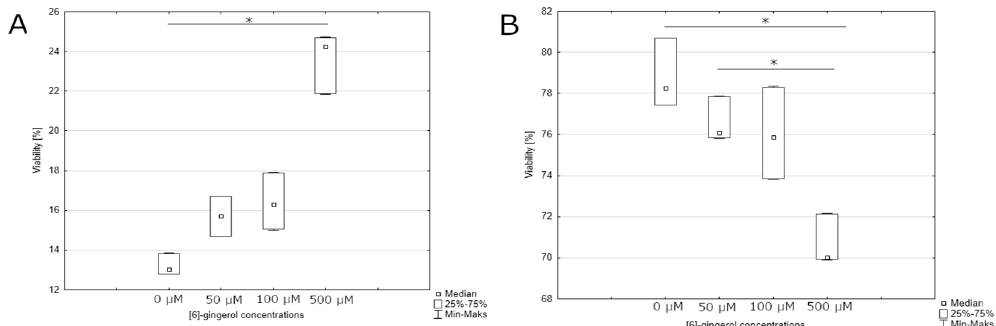
Figure 10. ( A ) assessment of the percentage of late stage of apoptotic or dead cells after 48 h incubation depending on the concentration of [6]-gingerol. The representative experiment is a median and a di ff erence between [6]-gingerol concentration and the control evaluated using ANOVA Friedman p = 0.00094 and post-hoc tests * p < 0.05; ( B ) e ff ect of increasing [6]-gingerol concentration on U-118MG living cells percentages after 48 h incubation using Muse TM Caspase-3 / 7 Reagent and 7-AAD staining. The representative experiment is a median and a di ff erence between [6]-gingerol concentration and the control evaluated using ANOVA Friedman p = 0.0029 and post-hoc tests * p < 0.05.